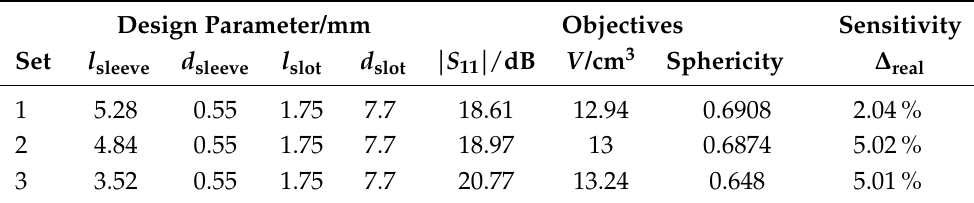
Table 2. Design parameter and objective values from Pareto-optimal parametric sets.